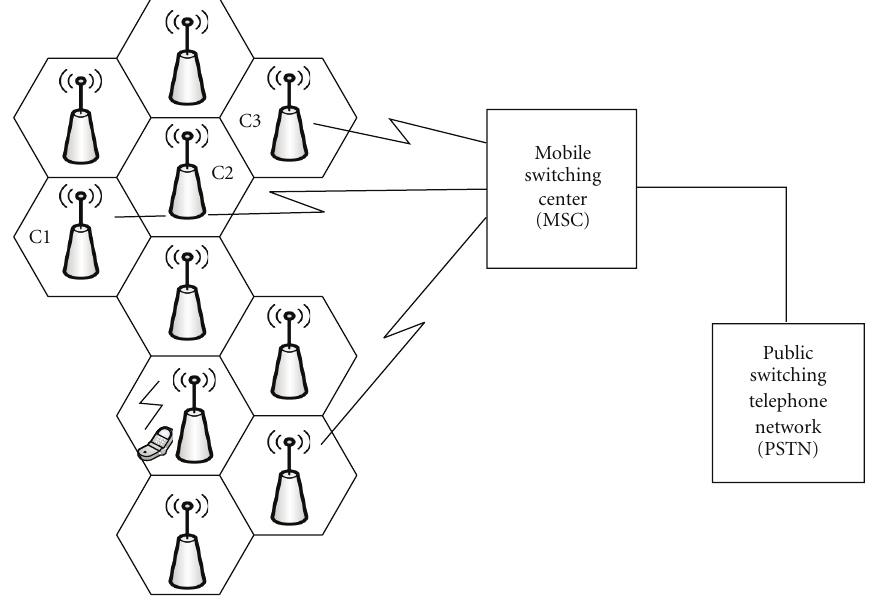
Figure 1: A typical cellular system